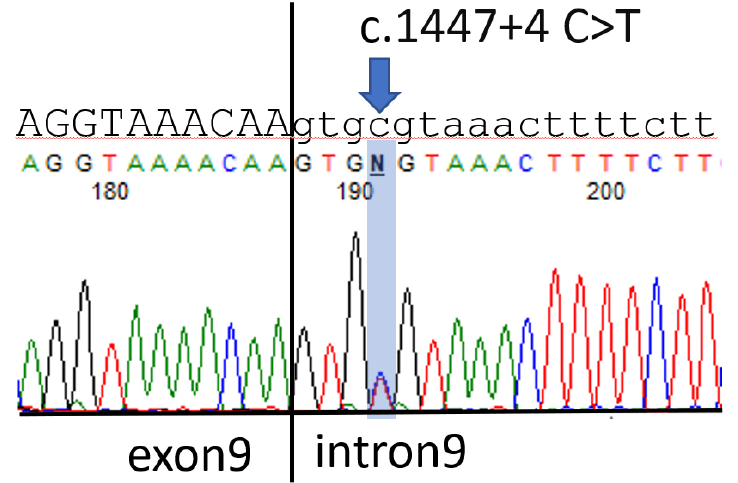
Figure 2. The uppercase and lowercase letters represent the sequences of exon9 and intron9 of WT1 gene respectively. Arrow indicates the c.1447 + 4 C > T mutation.